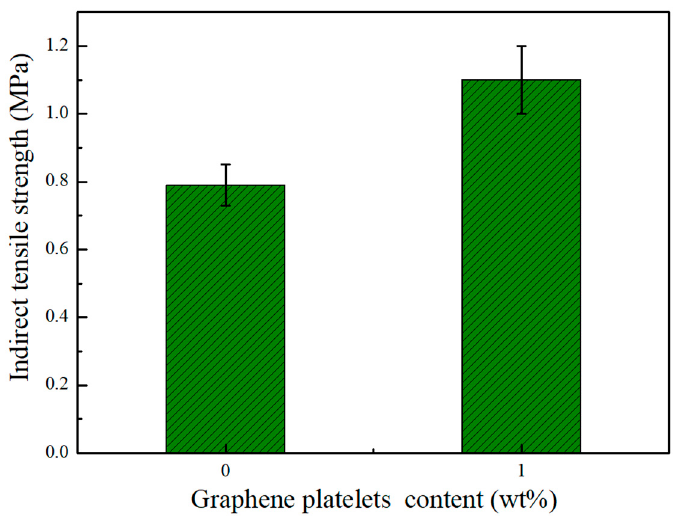
Figure 13. Indirect tensile test results of unmodified asphalt mixtures and GnPs-modified asphalt